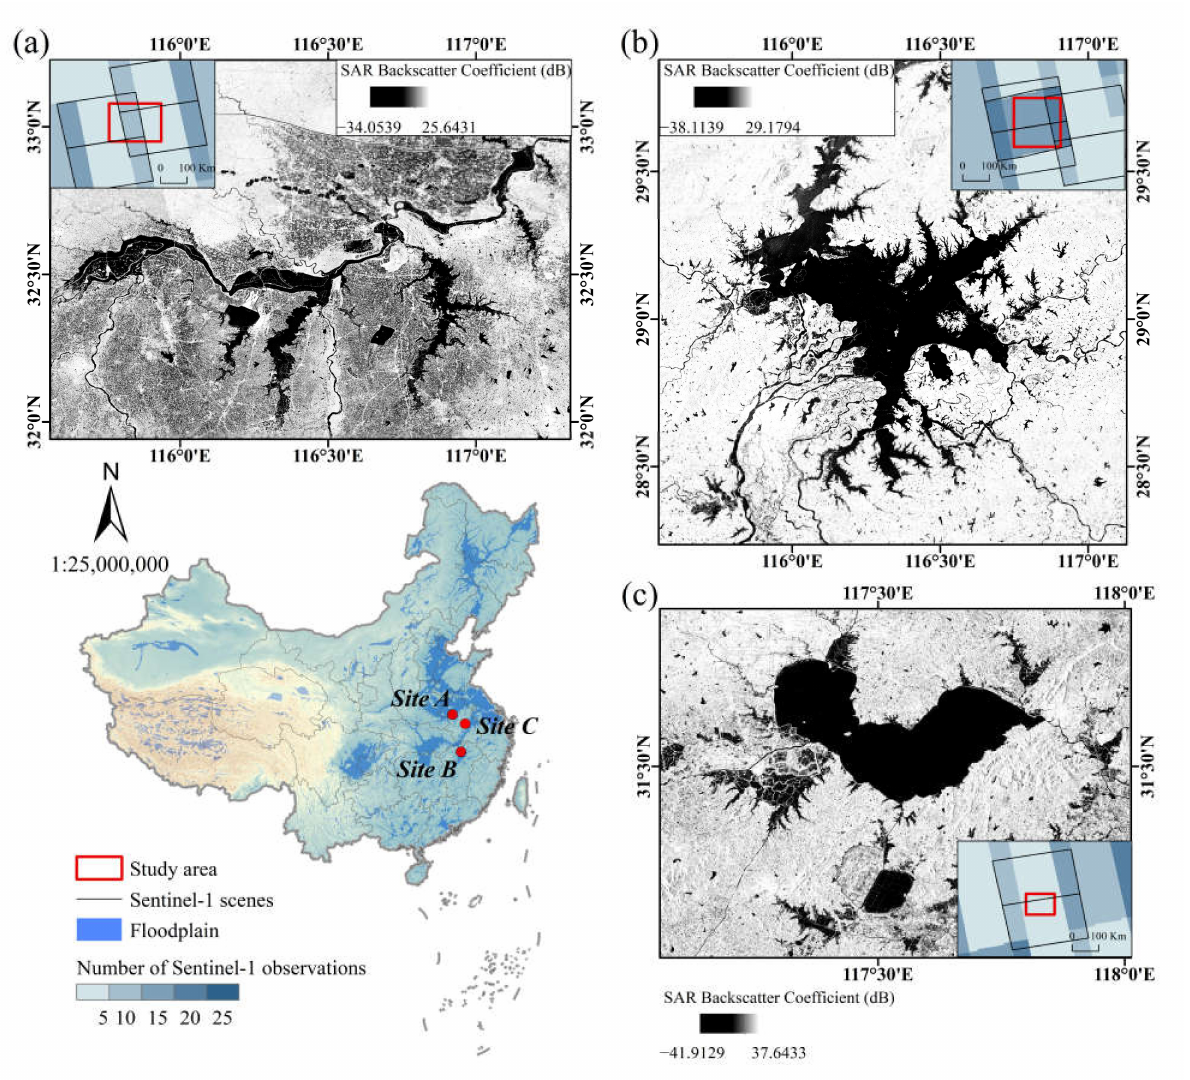
Figure 1. Geographic locations, flooding extents, and available Sentinel-1 imagery in July and August 2020 at three study areas: ( a ) the Huai River, ( b ) the Poyang Lake and, ( c ) the Chao